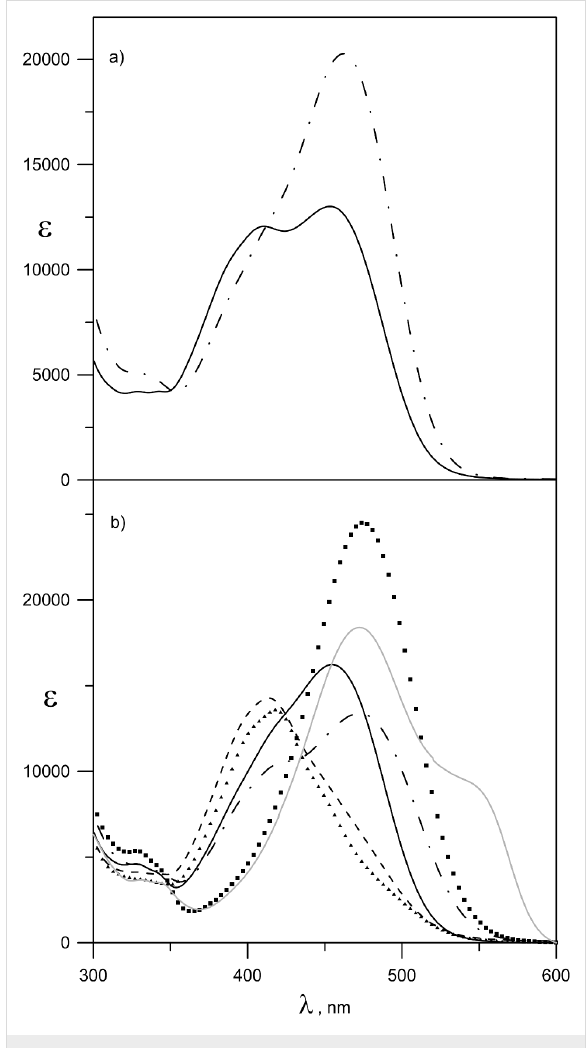
Figure 2: Absorption spectra of compounds 1 (a) and 6 (b) in aceto- nitrile ( — ), chloroform ( − · − ), dichloromethane ( --- ), ethanol ( ■■■ ), toluene ( ▲▲▲ ) and dimethylformamide (grey solid